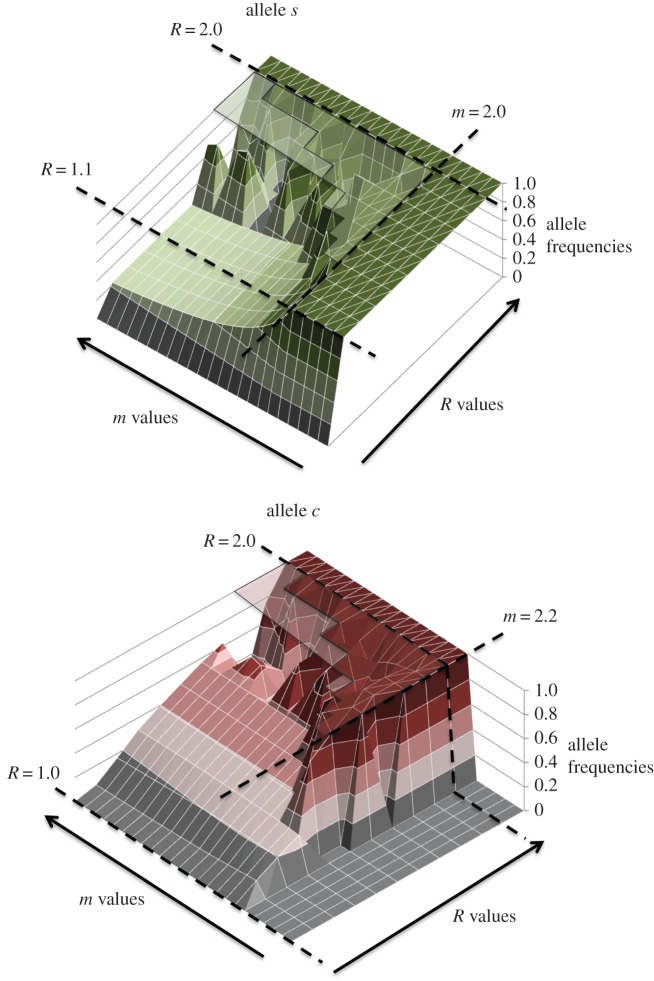
Parameter space of frequencies of alleles s and c at generation 10 000 for the example in table 4. Figure shows allele frequencies at t=10 000. Cells within the parameter space represent cases that reached stable equilibria or instances in continuous oscillations (graph area indicated by ‘*’), some of which (**) reached values very close to fixation or extinction (1 or 0) with only traces of the competing alleles that can resume the cycles thanks to the infinite size of the modelled population (see table 4 for details of cell values, and figure 2 for the dynamics of alleles in three example cases within the parameter space). Variations in conditions can be explored with the provided R script ([61] and the electronic supplementary material).